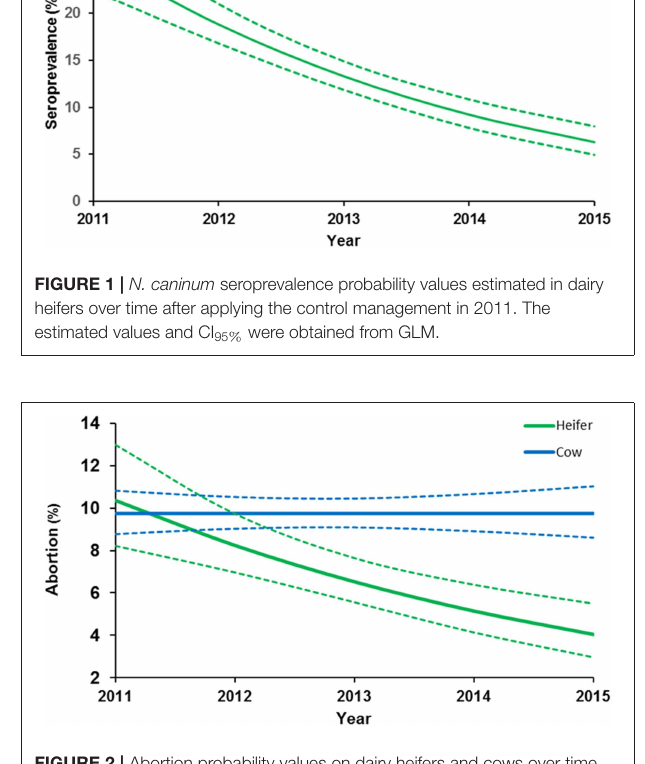
FIGURE 2 | Abortion probability values on dairy heifers and cows over time after applying the control management in 2011. The estimated values and CI 95 % were obtained from GLM.